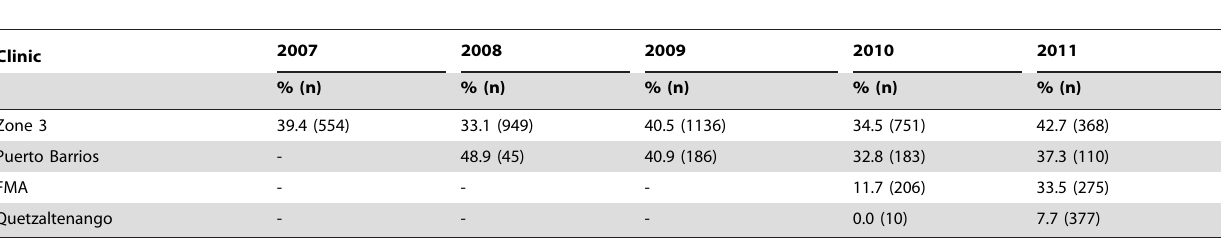
Table 4. Distribution of FSW who returned for a follow-up visit within 1 year of initial visit by clinic, Guatemala, 2007–2011.